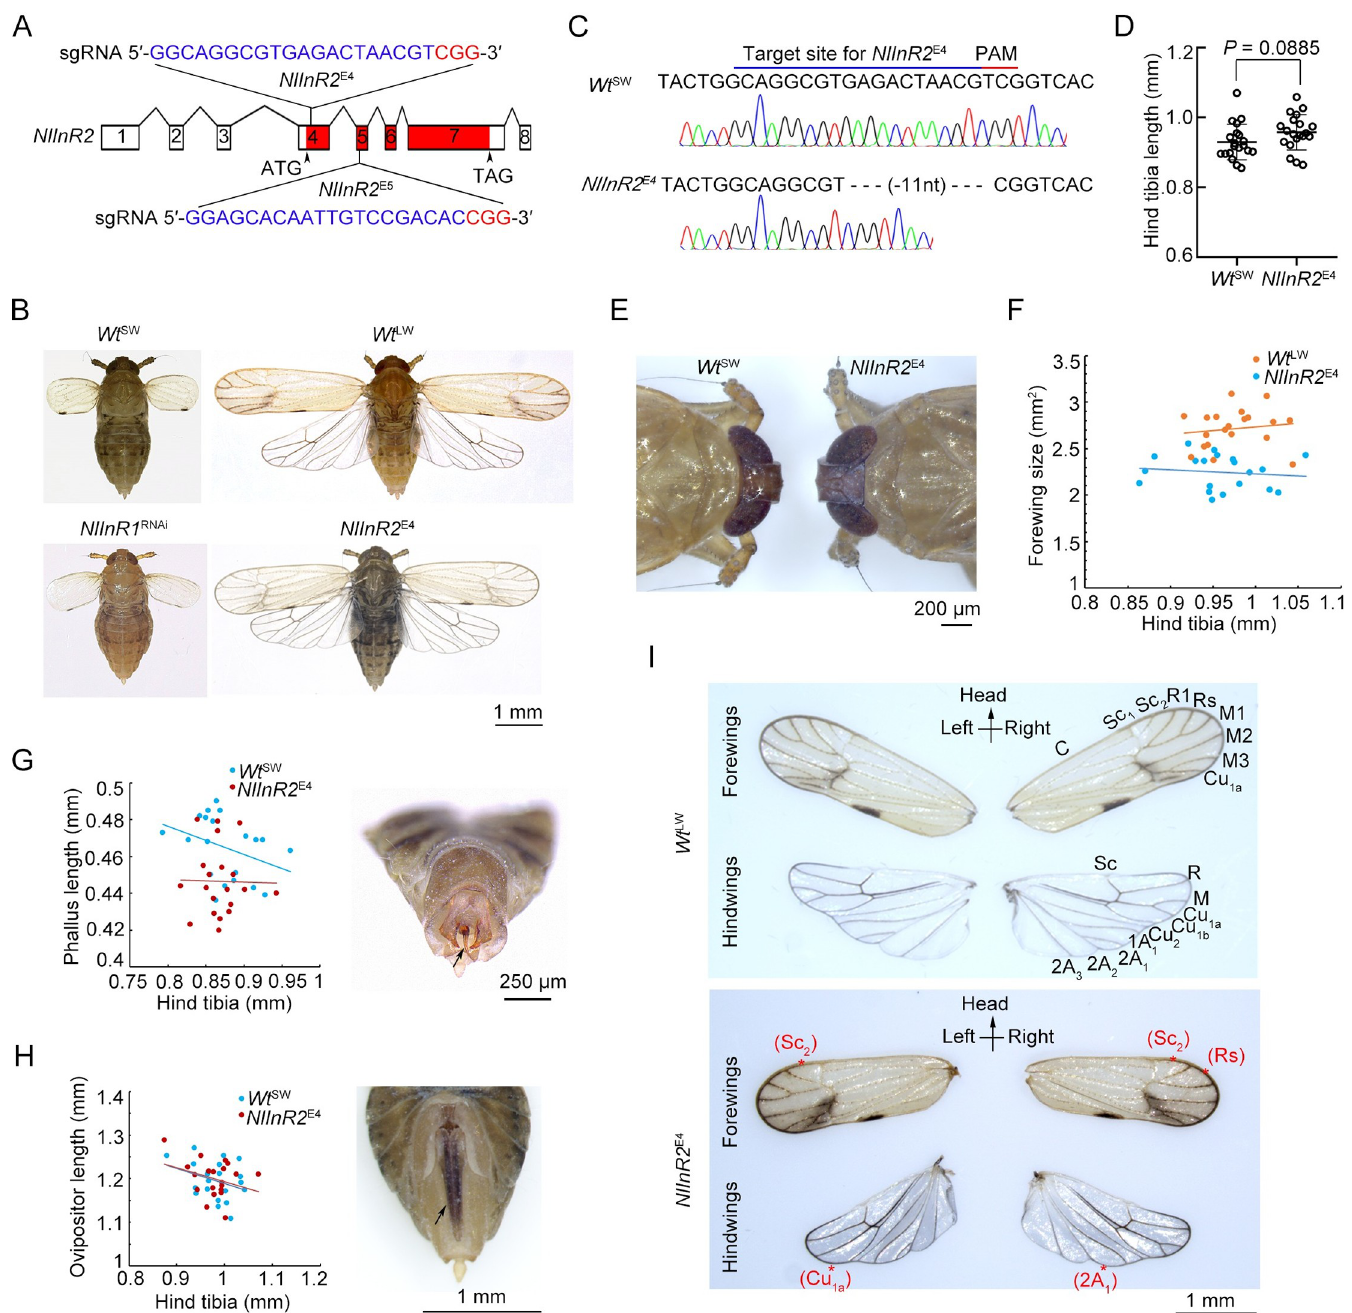
Fig 1. CRISPR/Cas9-mediated mutations at the NlInR2 locus. (A) Schematic diagram of sgRNA-targeted sites in exons 4 and 5 of NlInR2 . Exons composing the Nl InR2 cDNA were indicated by numbers, and the encoding region of NlInR2 was indicted by exons in red. Target sequences for generating NlInR2 mutations indicated in blue and the PAM indicated in red, which were located at 36 to 54 nucleotide (nt) downstream of the NlInR2 start coden (ATG) in exon 4. (B) Morphologies of BPHs. Wt SW , wild-type short-winged BPHs; Wt LW , wild-type long-winged BPHs; NlInR1 RNAi , RNAi-mediated knockdown of NlInR1 in Wt SW BPHs; NlInR2 E4 , homozygous NlInR2 -null mutants derived from Wt SW BPHs. (C) Sanger sequencing of region flanking target sites in NlInR2 E4 BPHs. Exon 4 of NlInR2 E4 locus had an 11-nt deletion. (D) Hind tibia length of Wt SW ( n = 20) and NlInR2 E4 ( n = 20) females. Statistical comparisons was performed using a two-tailed Student’s t -test ( �� , P < 0.01 and ���� , P < 0.0001), and bars represent mean ± s.e.m. (E) Head sizes of Wt SW and NlInR2 E4 females. (F) Relative forewing size and hind tibia length in Wt SW ( n = 20) and NlInR2 E4 ( n = 20) females. (G) Relative phallus and hind tibia length in Wt SW ( n = 20) and NlInR2 E4 ( n = 20) males. The morphology of male external genitalia was shown on the right and the phallus was indicated by an arrow. (H) Relative ovipositor and hind tibia length in Wt SW ( n = 20) and NlInR2 E4 ( n = 20) females. The morphology of female external genitalia was shown on the right and the ovipositor was indicated by an arrow. Each dot in ( D ), ( F ), ( G ), and ( H ) represents the forewing size derived from an individual female. (I) Vein patterning in forewings and hindwings of NlInR2 E4 and Wt LW BPHs. Normal veins were labeled in Wt LW forewings and hindwings. Missing veins in forewings (Sc 2 or Rs) and hindwings (Cu 1a or 2A 1 ) of NlInR2 E4 indicated by stars.